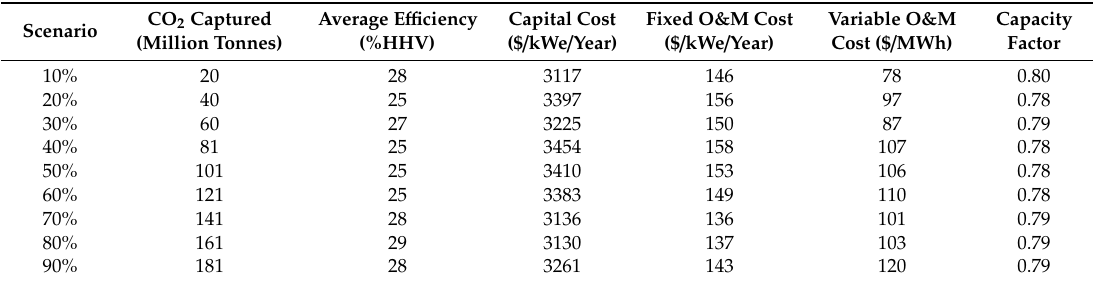
Table 4. Average e ffi ciency (%HHV), capital cost ($ / kWe), fixed O&M cost ($ / kWe / year), variable O&M